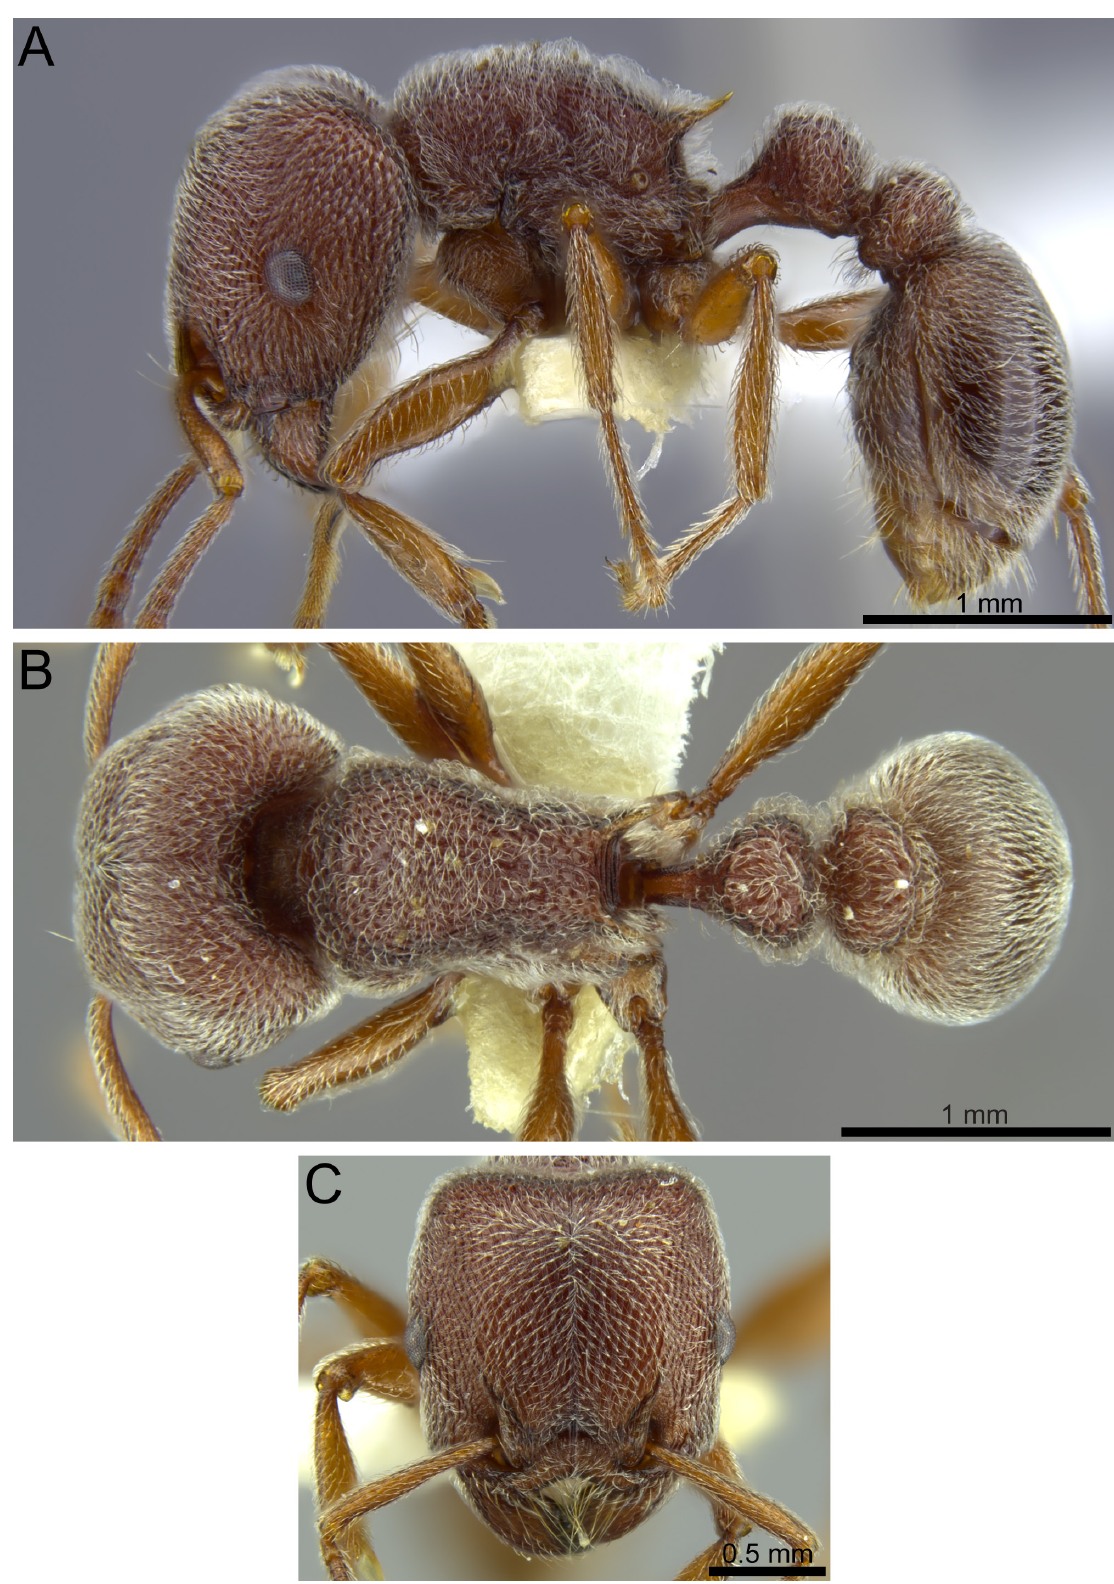
Fig. 19. Tetramorium rothschildi (Forel, 1907) (CASENT0764434). A . Body in profile. B . Body in dorsal view. C . Head in full-face